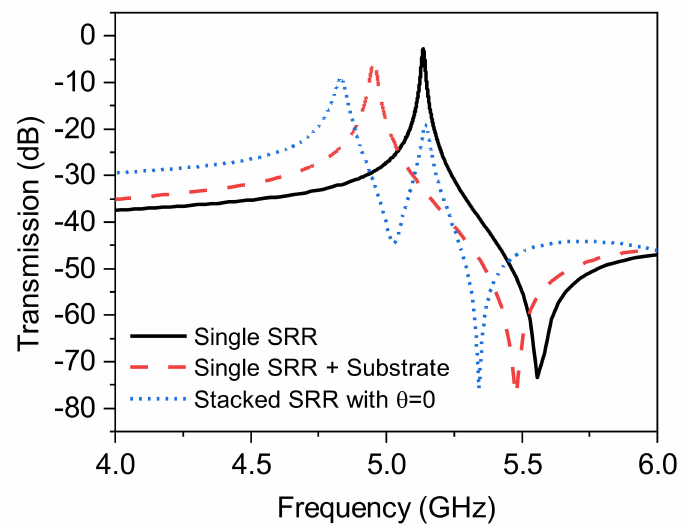
Figure 9. Electric field distribution of the stacked DSRR with various skew angles of 0, 45, 90, 145, and 180 deg, simulated with HFSS.